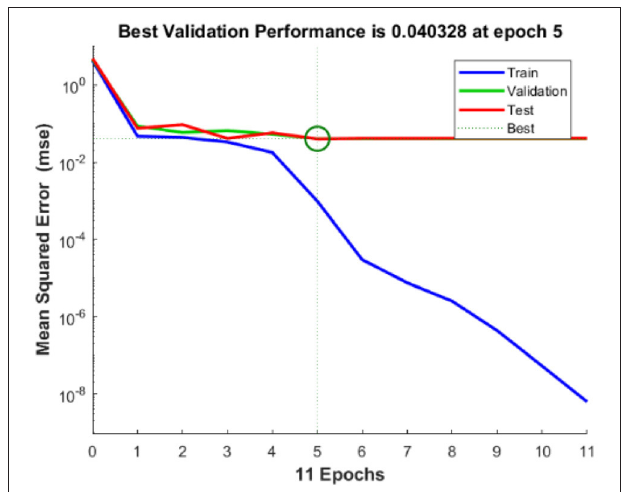
FIGURE 14 | Training state analysis of neural network based on the ID function model of the neuron.